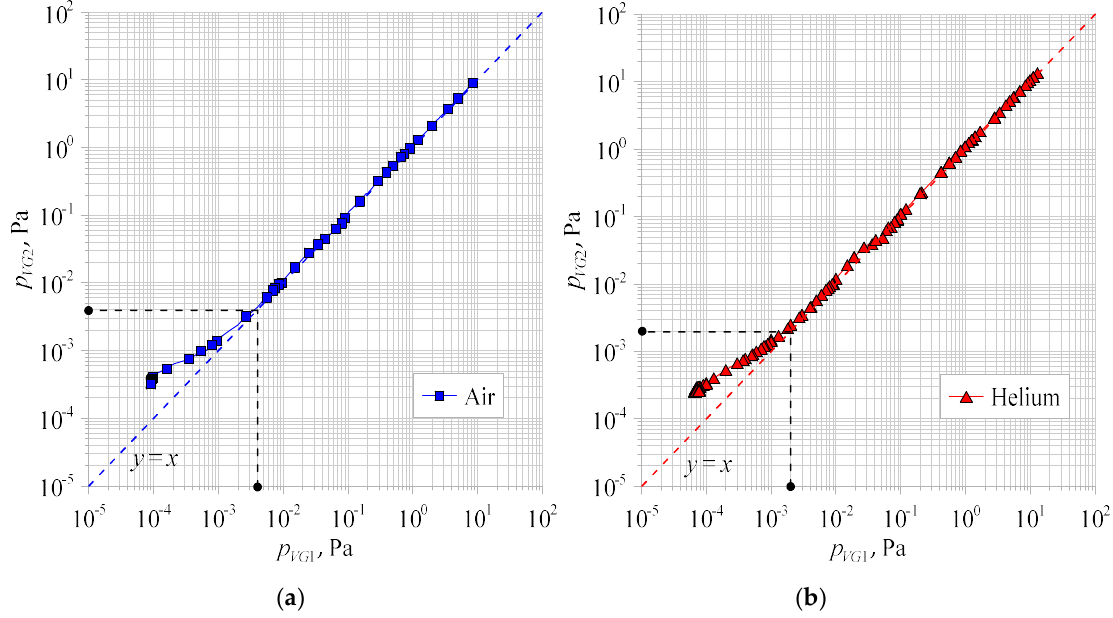
Figure 5. Dependence of the pressure measured by vacuum gauge VG1 on the pressure measured by vacuum gauge VG2 taking into account correction factors for ( a ) air and ( b ) helium.